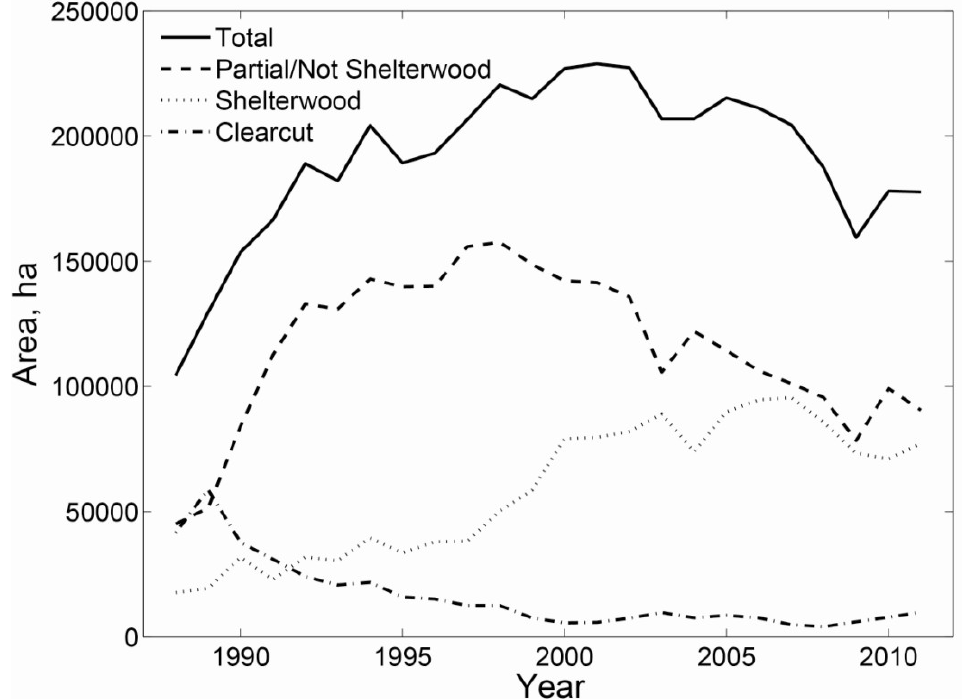
Figure 7. Total forest area harvested in Maine, 1988–2011, by type of